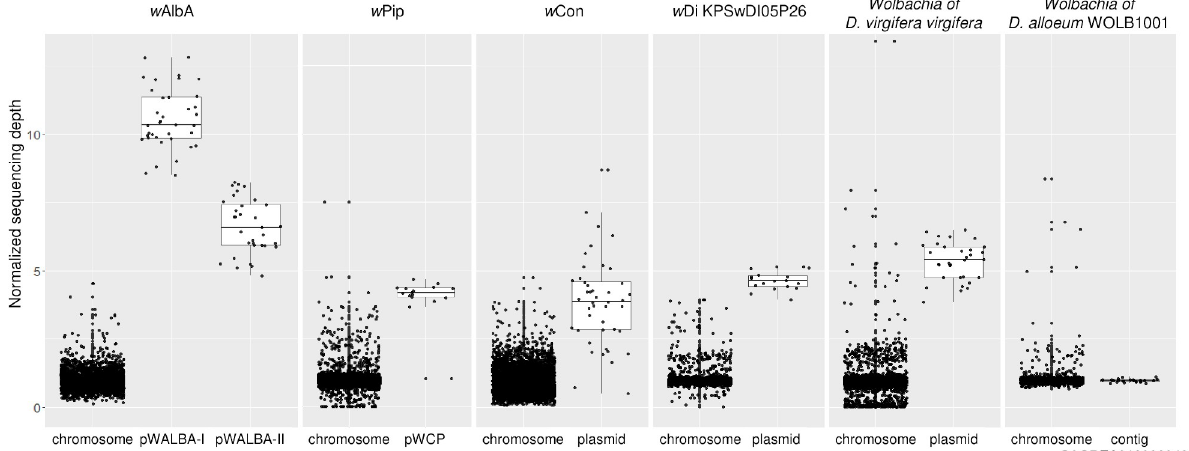
Fig 3. Relative sequencing depth of Wolbachia -associated plasmid-like elements. Each dot indicates the mean sequencing depth in 500 bp windows divided by the mean chromosome depth.